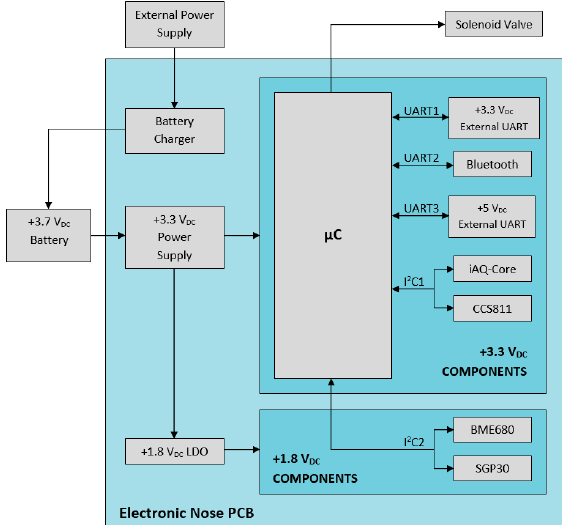
Figure 2. Block diagram of the electronic